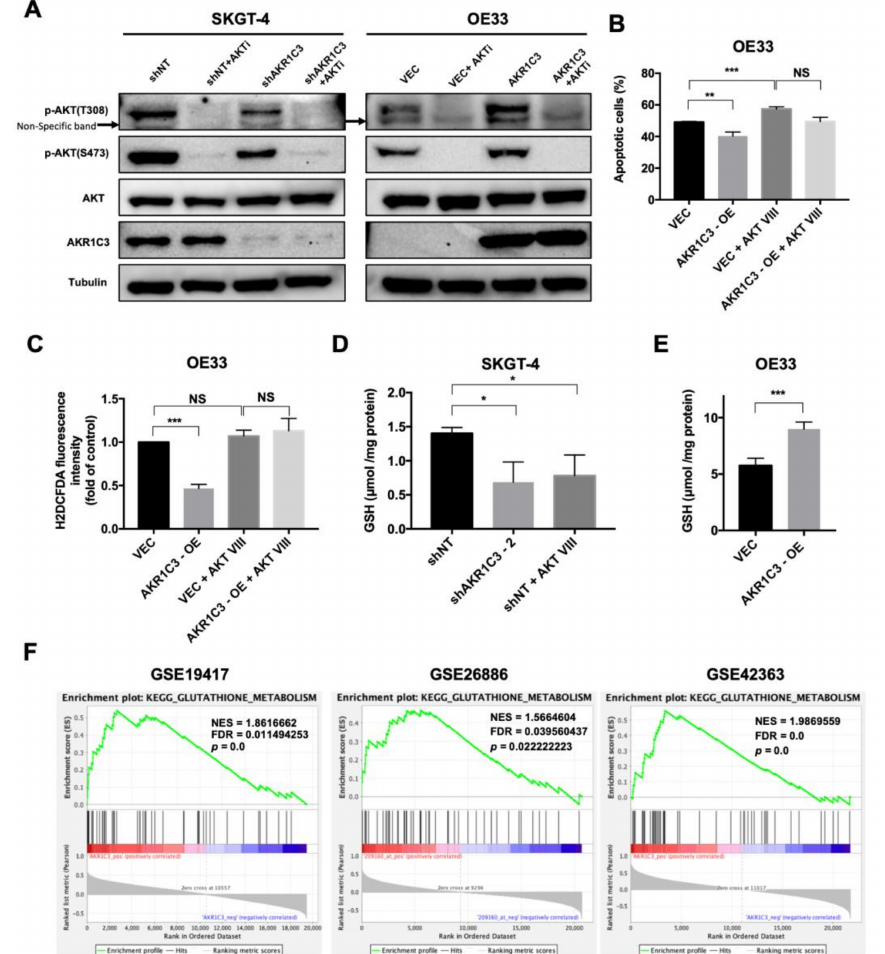
Figure 5. AKT phosphorylation was regulated by AKR1C3 and was responsible for ROS alleviation in EAC. ( A ) Western blot showed that the phosphorylation level of AKT was downregulated in AKR1C3 knockdown cells and upregulated in AKR1C3 overexpressing cells, and the